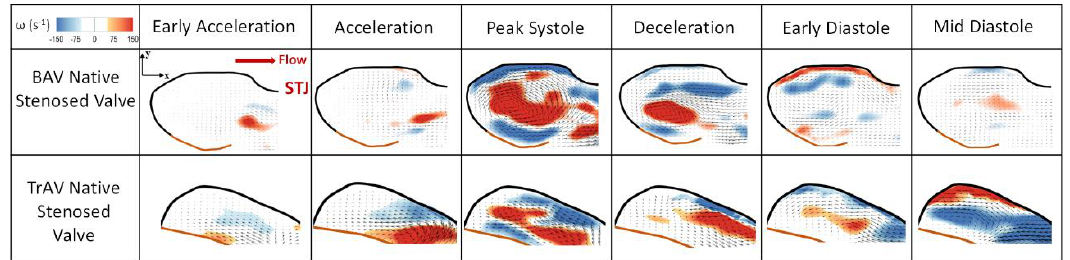
Figure 2. Velocity vectors and vorticity contours within the native bicuspid and native tricuspid valve sinuses at selected time points throughout the cardiac cycle. STJ denotes sinotubular junction.